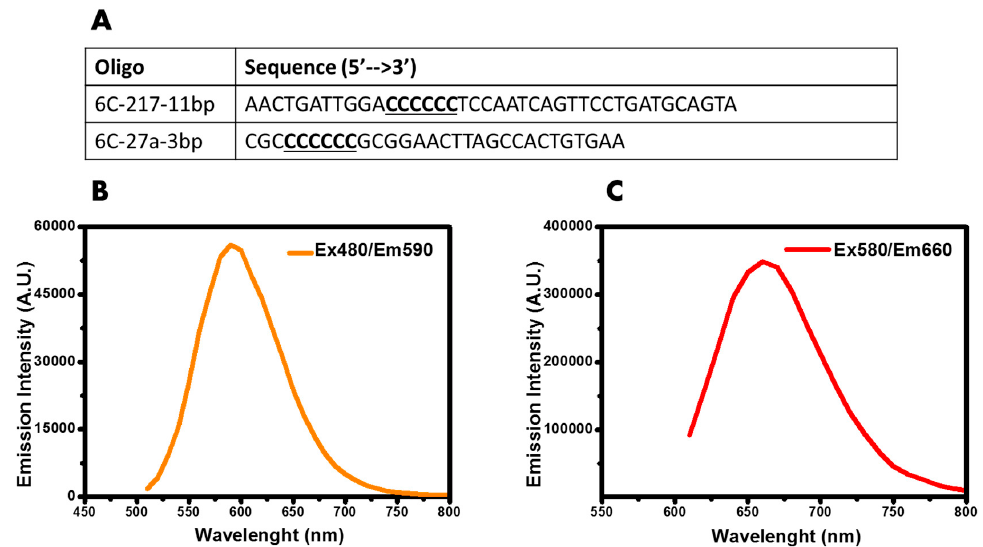
Figure 1. ( A ) Name and 5’ to 3’ sequence of the DNA templates used in the study. ( B ) Fluorescence of DNA 6C-217-11bp with Ex / Em wavelength 480 / 590 nm. The fluorescence was measured after 60 min of synthesis. ( C ) Fluorescence of DNA 6C-27a-3bp with Ex / Em wavelength 580 / 660 nm. The fluorescence was measured after 60mins of synthesis.